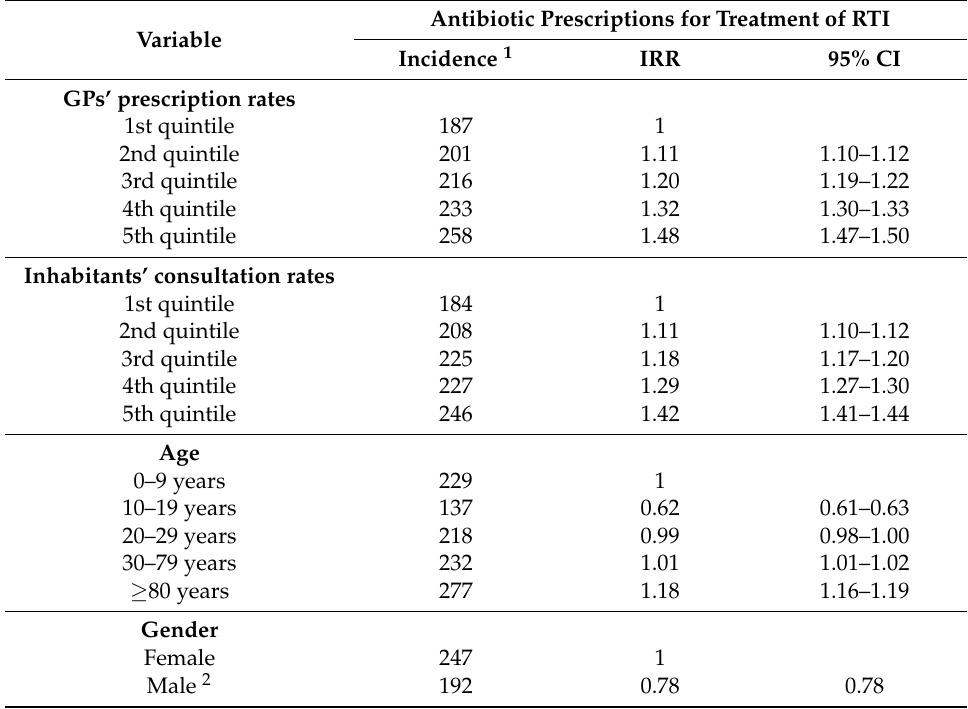
Table 3. The effect on total use of antibiotics for RTIs, mixed linear Poisson regression